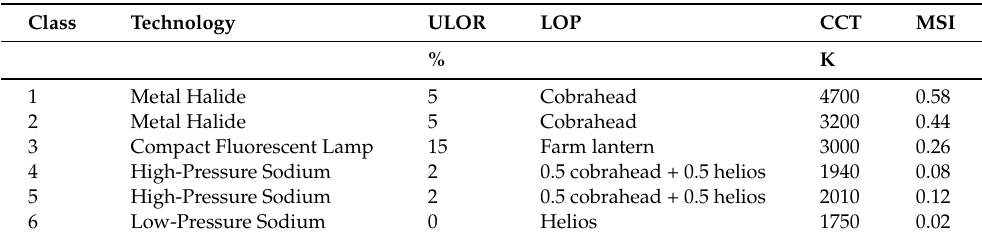
Table 1. Light fixtures characteristics per spectral class. The Correlated Color Temperature (CCT) and MSI are also given for each spectrum.